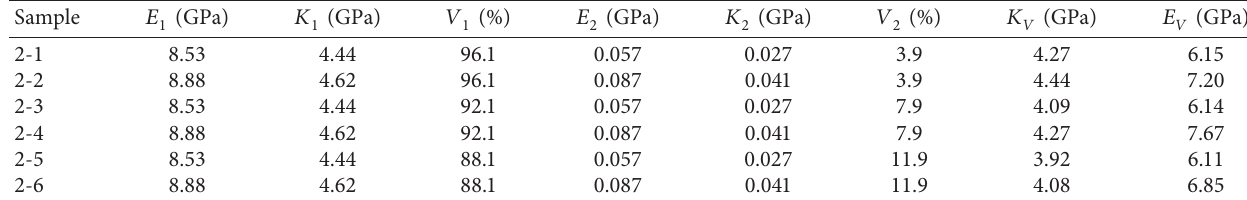
Table 2: The equivalent elastic parameters of the filled fractured rock.